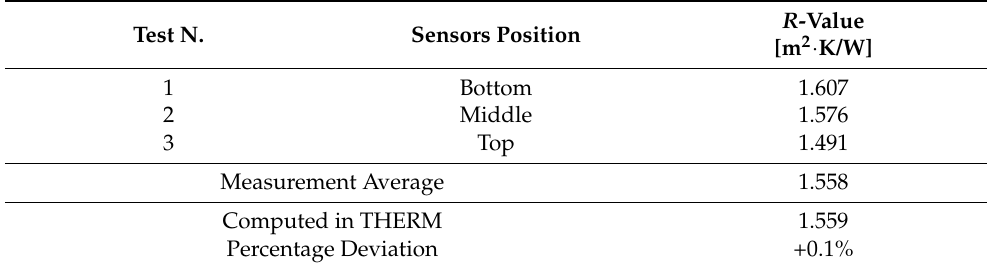
Table 4. Reference LSF partition wall surface-to-surface R -values for both the experimental and numerical approaches. Percentage deviation included. Test